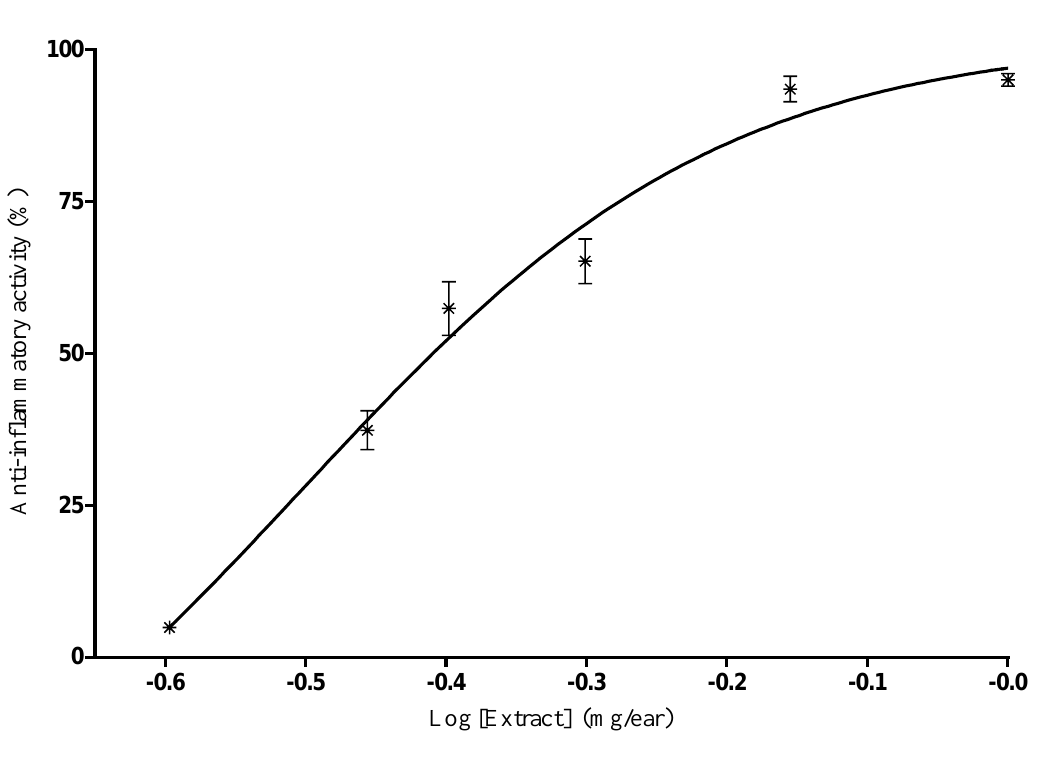
Figure 1. Anti-inflammatory activity of the apolar extract from Galaxaura marginata . Mice left ears were topically treated with croton oil and apolar extract. After 3h incubation, edema inhibition was determined. The EC calculated from quintuplicate